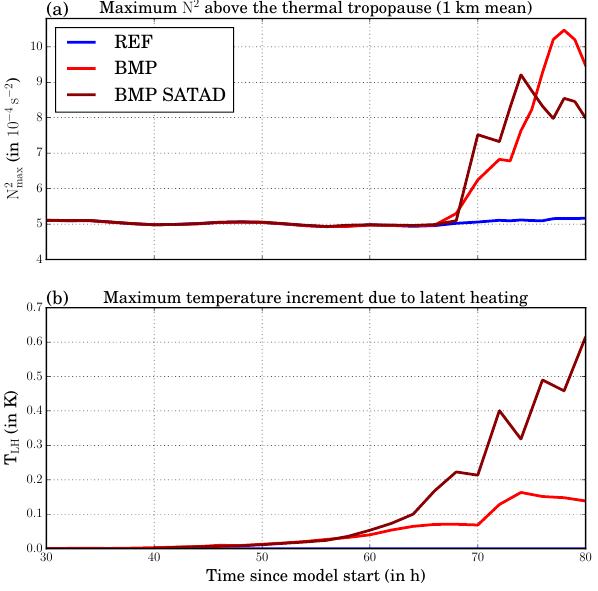
Figure 5. Temporal evolution between 30 and 80h after simulation start of (a) the maximum static stability N 2 max (in 10 − 4 s − 2 ) above the thermal tropopause and (b) the maximum temperature incre- ment due to latent heating T LH (in K) in the model domain for REF (blue lines), BMP (red lines), and BMP SATAD (dark red lines). N 2 . These averages are obtained between 25 and 65 ◦ N in the meridional direction and in the entire zonal